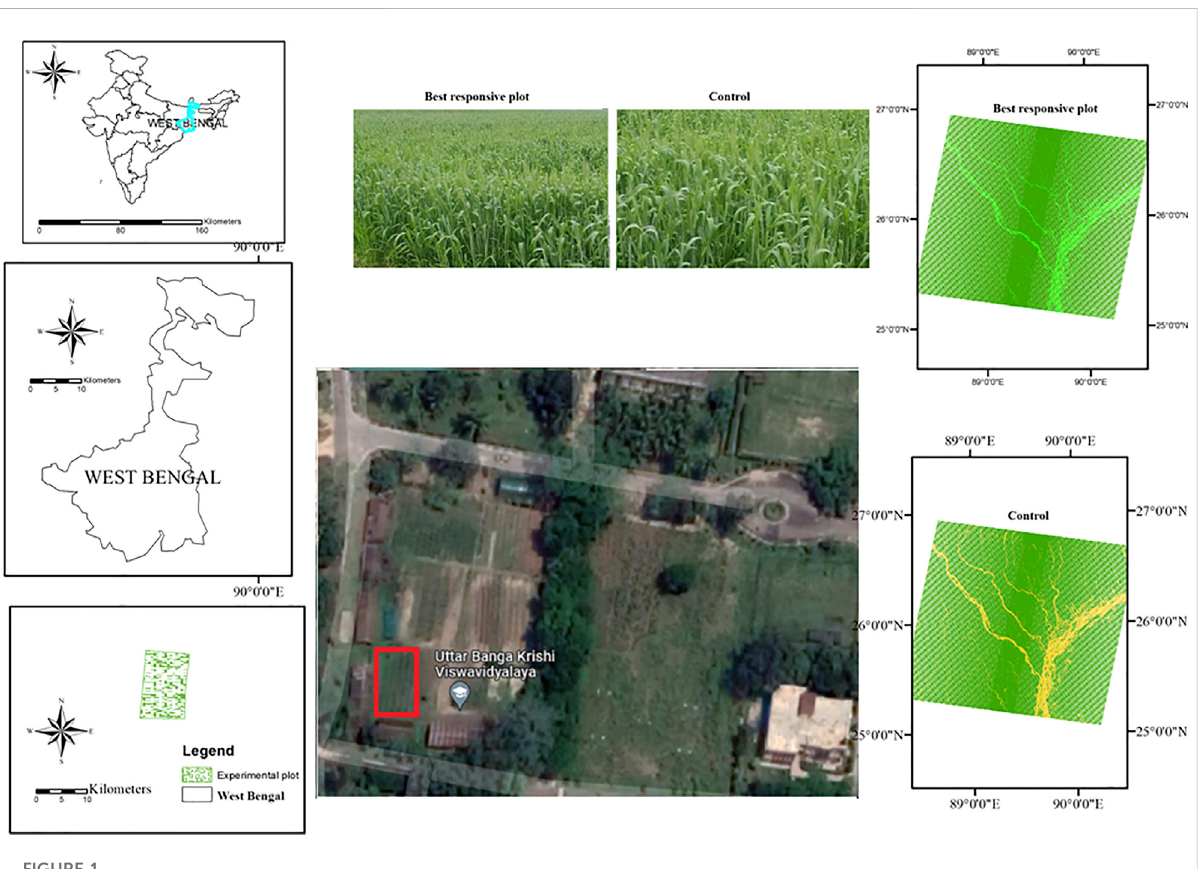
FIGURE 1 Location map of the study